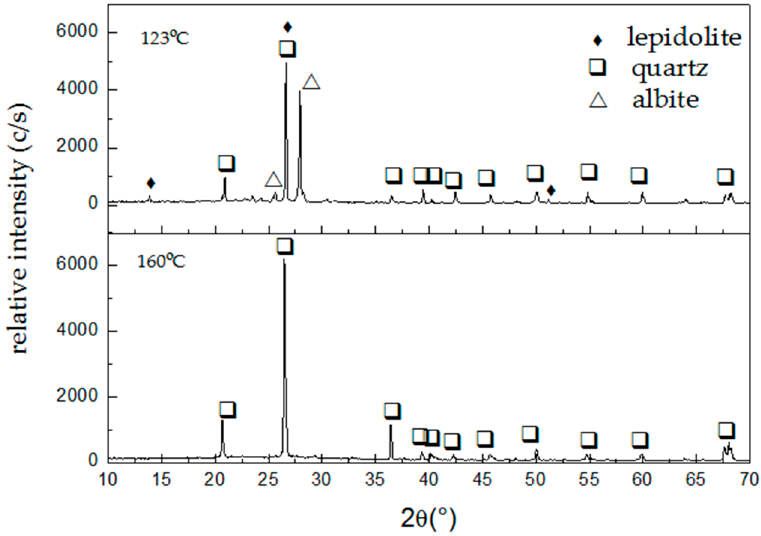
Figure 6. XRD patterns of the leaching residue obtained at 123 and 160 °C.